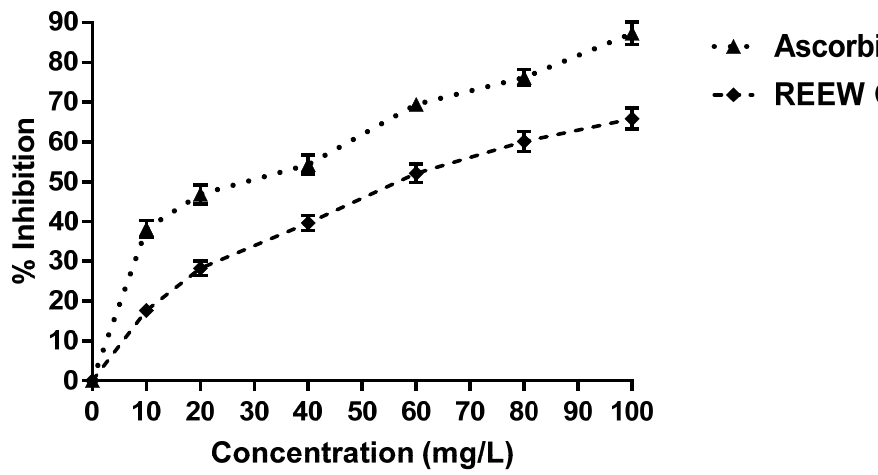
Figure 7. H 2 O 2 scavenging assay of REEW-GNs and ascorbic acid (standard), showing percent H 2 O 2 inhibition at various experimental doses.